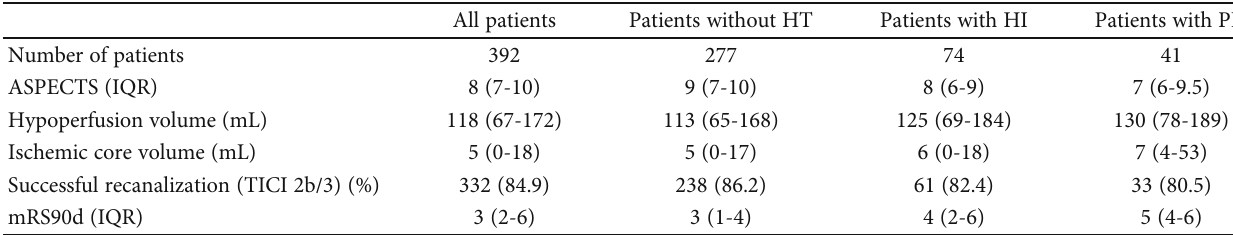
Table 2: Radiological data and